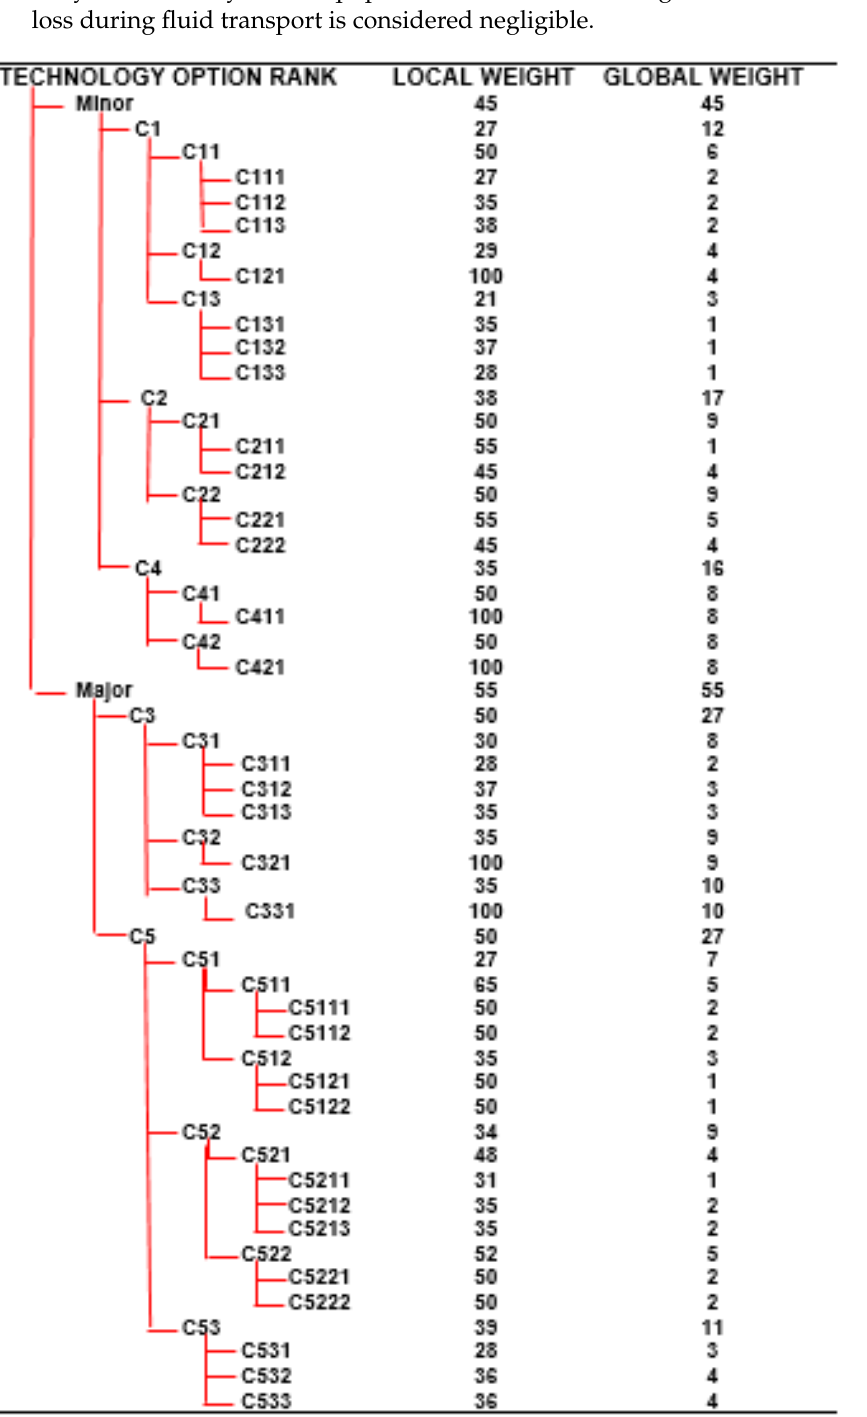
Figure 1. Algorithm for the decision analysis with weights of the basic attributes.